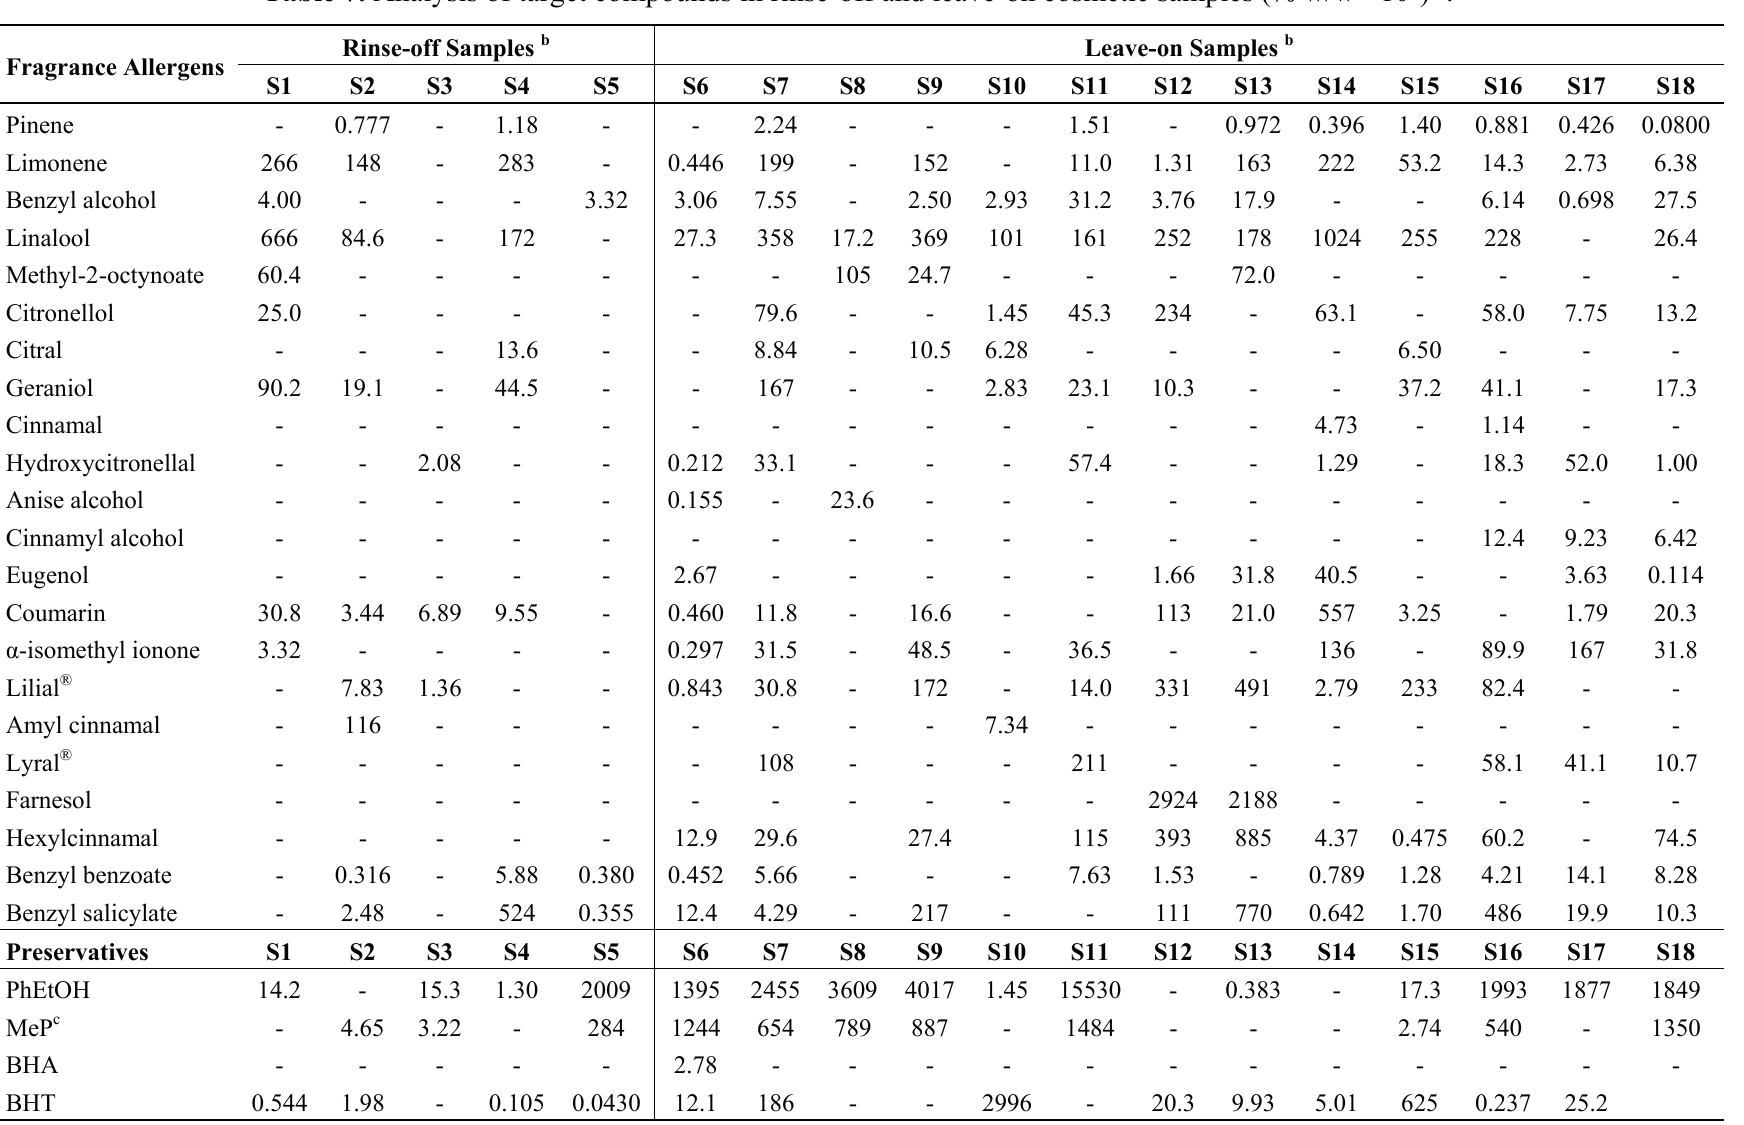
Table 7. Analysis of target compounds in rinse-off and leave-on cosmetic samples (% w/w ×10 4 ) a . Fragrance